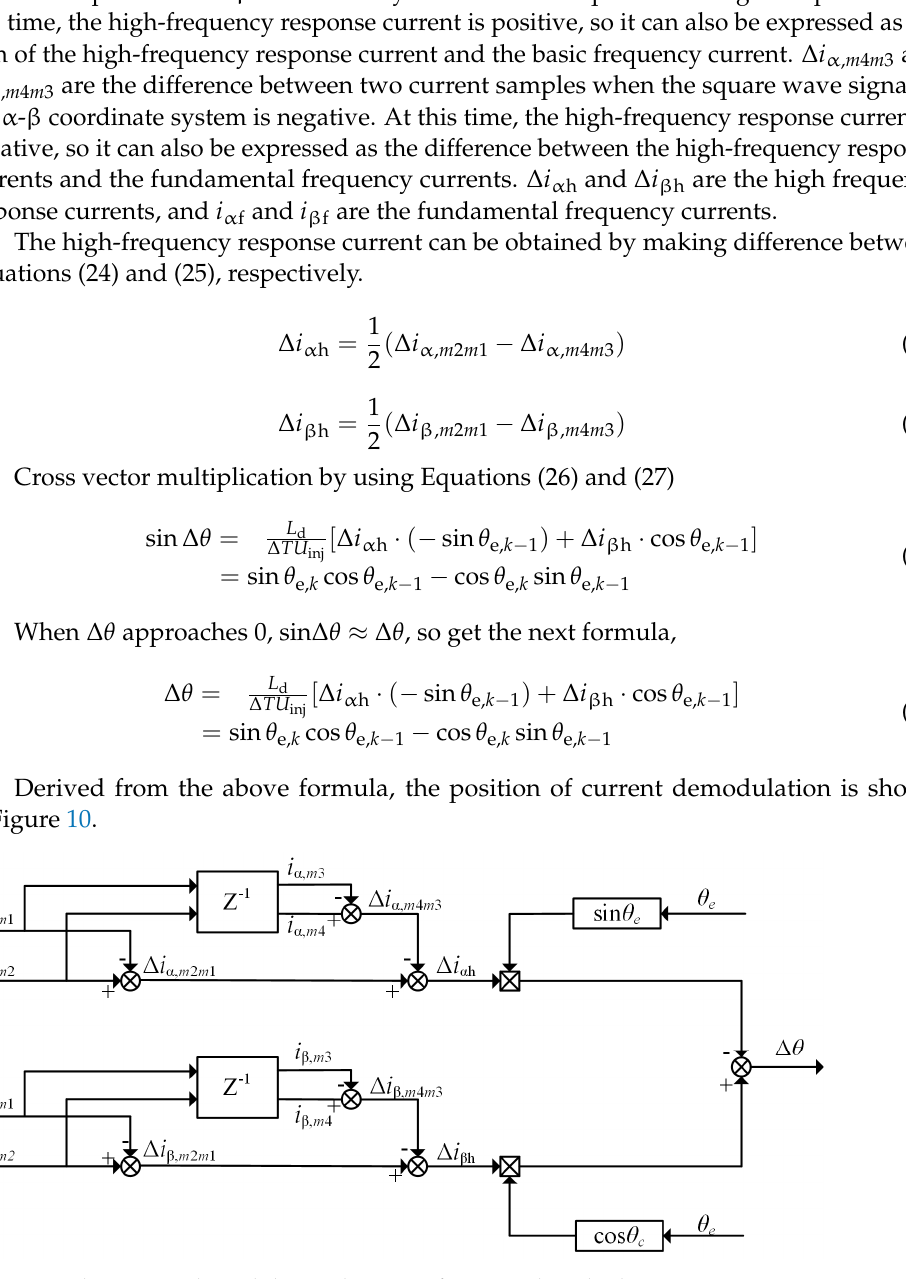
Figure 10. The current demodulation diagram of proposed method.